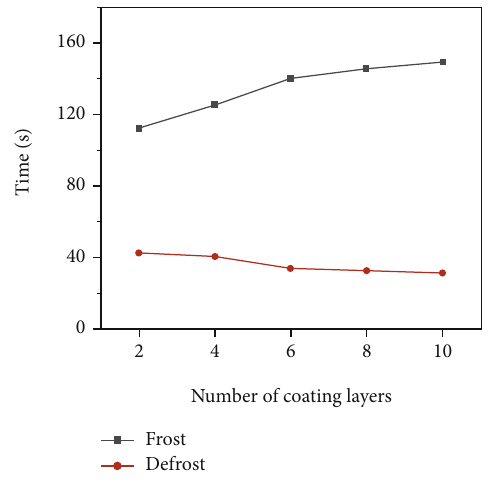
Figure 8: Frost/defrost time of di ff erent coating.